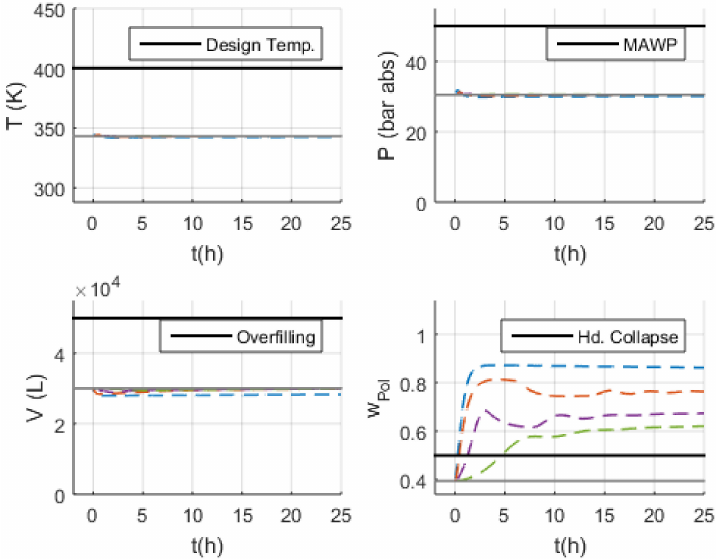
Figure 13. Behavior of critical variables in scenarios S-1 and S-2 with Model 1 and 2. Make-up